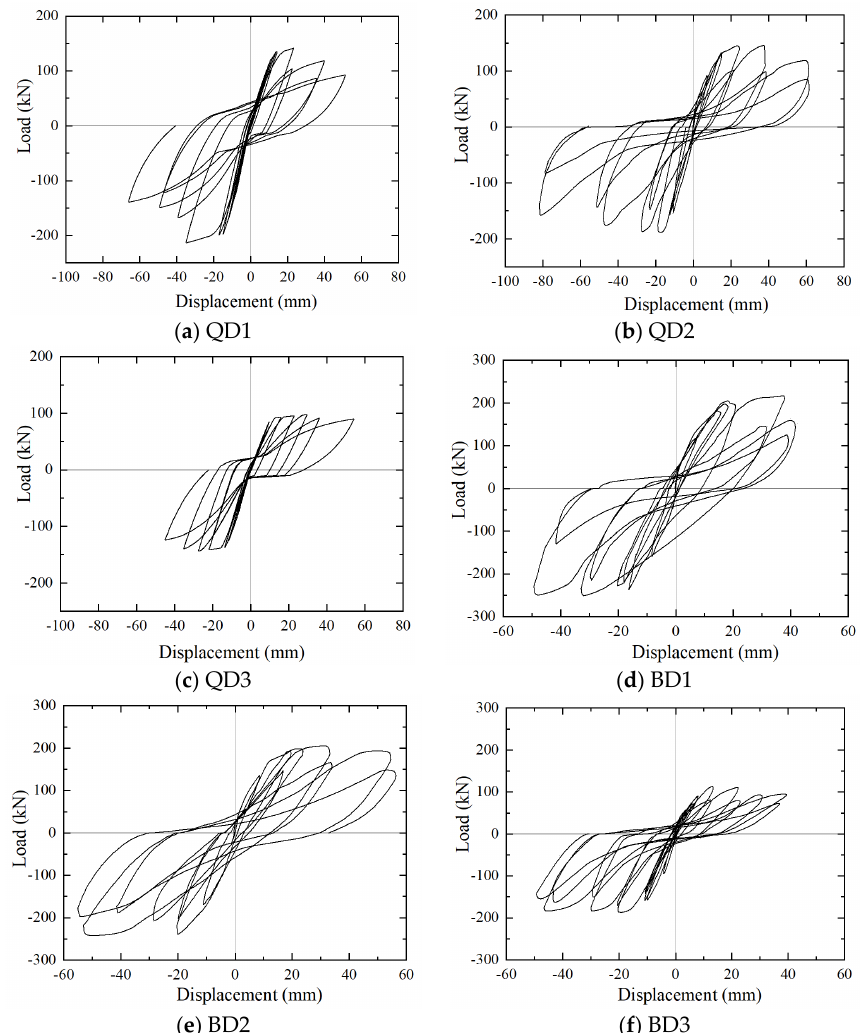
Figure 6. Hysteretic curves for six specimens. ( a ) QD1; ( b ) QD2; ( c ) QD3; ( d ) BD1; ( e ) BD2; ( f ) BD3. Appl. Sci. 2020 , 10 , x FOR PEER REVIEW